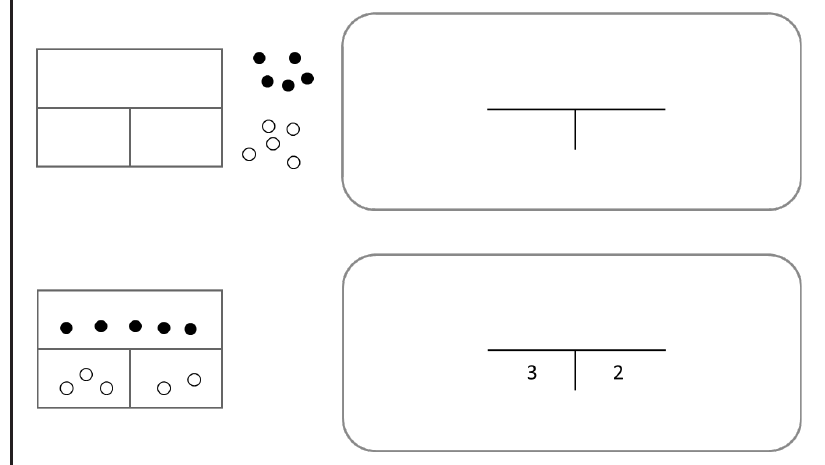
Figure 5: Part + Part – producing the whole with digits. (Several of the forms on the left can be placed on one